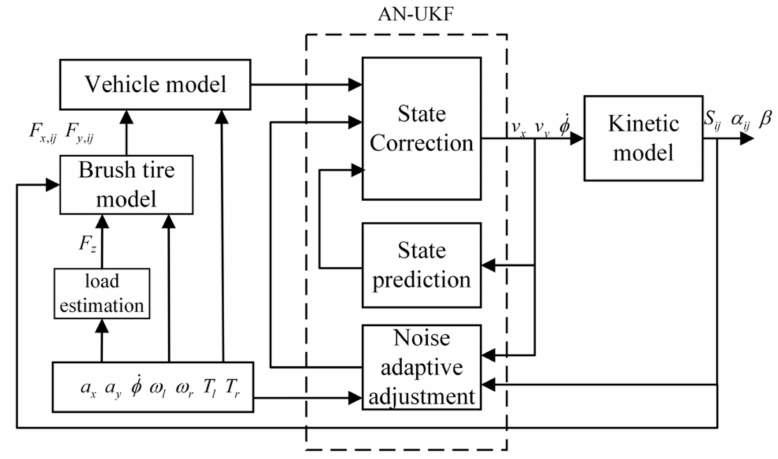
Figure 5. The structure of the observer.